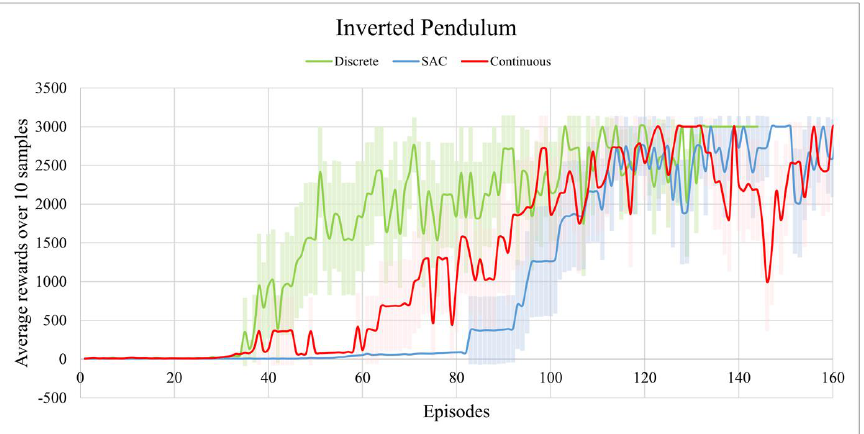
Figure 12. SAC, continuous algorithmic expert feedback, and discrete algorithmic expert feedback examined in openAI gym Inverted Pendulum averaged over 10 samples.